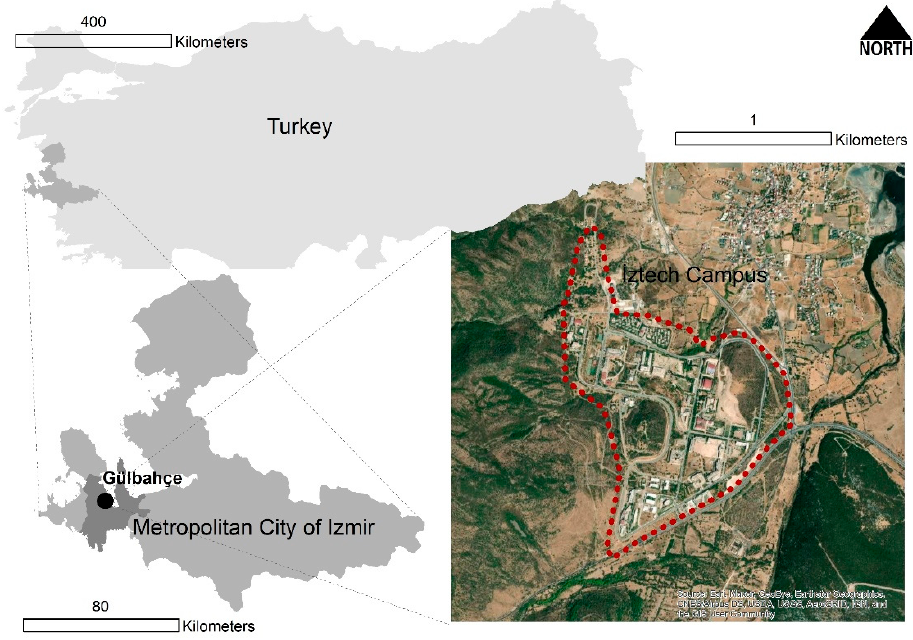
Figure 1. The area of interest.